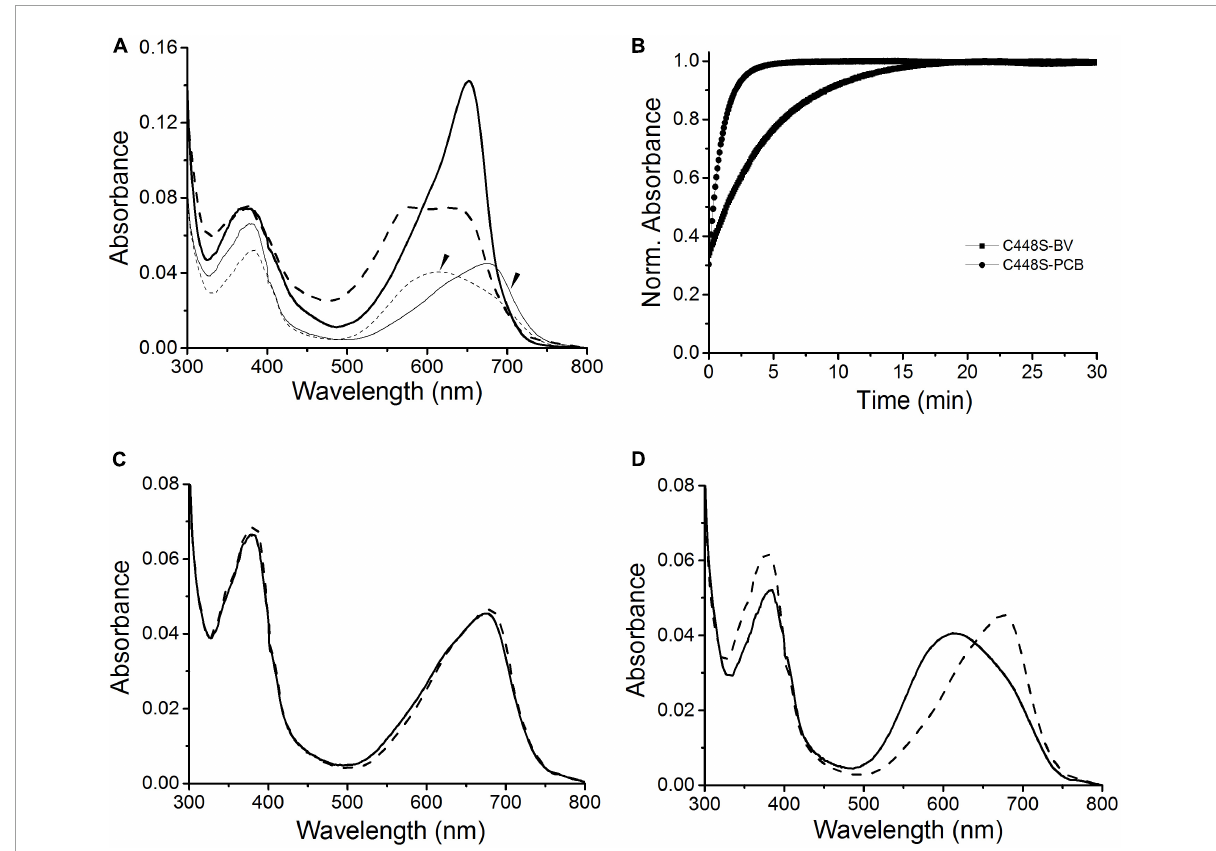
FIGURE2 Photoconversion and dark reversion of BV-binding C448S. (A) Absorbance spectra of native (heavy lines) and acid-urea denatured (thin lines indicated by the arrow) biliprotein. The dashed lines correspond to the native (heavy dashed line) and denatured (thin dashed line indicated by the arrow) 15E state obtained after irradiation with 653/20 nm light; (B) absorbance at 652 nm monitored after driving the biliprotein (C448S-BV) to the E-state. C448S-PCB represents the PCB-binding C448S as a control. (C) Absorbance spectra of the acid-denatured SPI1085g3 Po state: absorbance spectra just after denaturation (solid line) and after light illumination (dashed line). (D) Absorbance spectra of the acid-denatured SPI1085g3 Pr state: absorbance spectra just after denaturation (solid line) and after light illumination (dashed